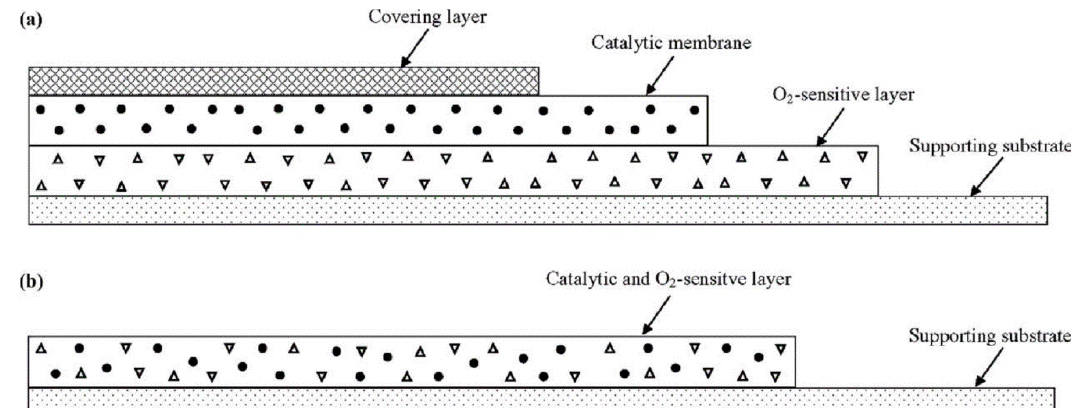
Figure 8. Composition of a typical ( a ) multilayer sensor membrane as used in [36] and ( b ) of a single-layer sensor membrane for reversible luminescence detection of H 2 O 2 via O 2 . Former multilayer schemes have the catalyst (  ) and luminophore (  ) encapsulated in different layers, whereas in [37] a single-layer system catalyst and luminophore are encapsulated in the same polymer matrix. Reproduced from [37] with permission of The Royal Society of